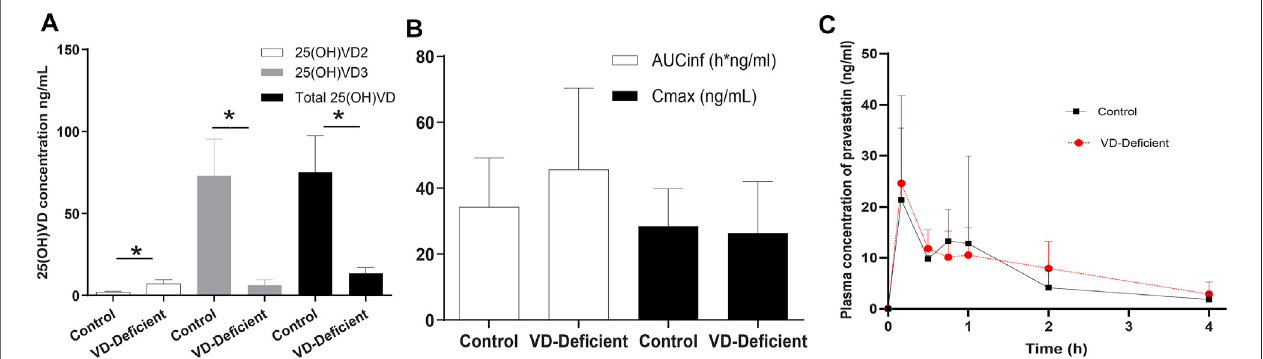
FIGURE 4 | Pravastatin pharmacokinetic study results in rats. (A) Plasma 25(OH)VD concentration after feeding for 25 days with a VD-supplement diet (Control group, n =6)oraVD-free diet(VD-de fi cient, n =9). Plasma25(OH)VDconcentrationinthede fi cient groupfedonaVD 3 -freedietwaslowerthanthatofthecontrolgroup (13.2 ± 6.26 ng/ml vs. 74.98 ± 22.30 ng/ml). (B) Pravastatin pharmacokinetics parameters. AUC inf in the VD-de fi cient group is slightly higher, but both AUC inf and C max are not signi fi cantly different inthe control and VD-de fi cient group. (C) Pravastatin time pro fi le concentration ofcontrol and de fi cient groups. AUC inf : area under the curvefrom the time ofdosing extrapolated to in fi nity, C max : maximum plasma concentration. p < 0.05: statistically signi fi cantdifference, using two-tailed unpaired t-test.